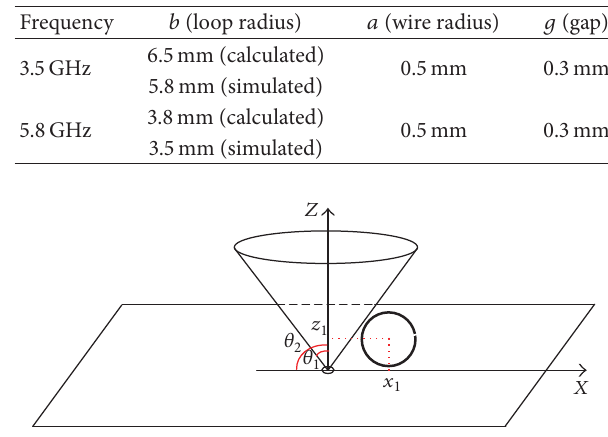
Figure 2: Input impedance of a conical type monopole antenna.